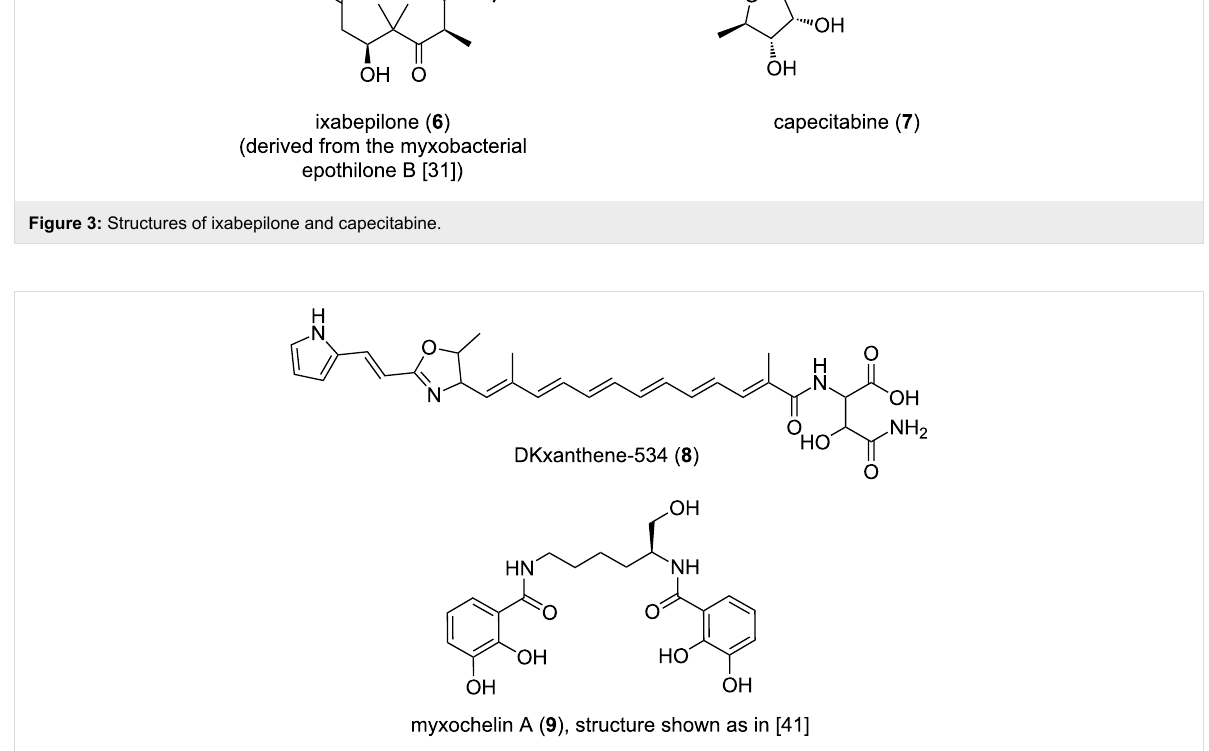
Figure 4: Structures of DKxanthene-534 and myxochelin